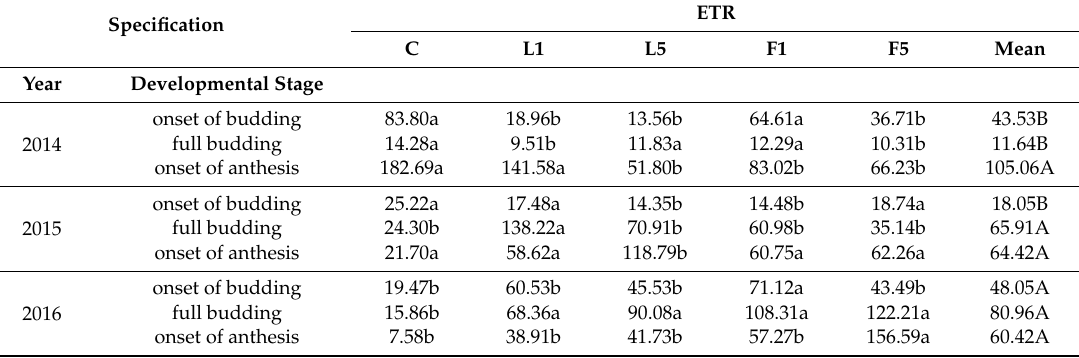
Table 3. Influence of electromagnetic stimulation on electron transport rate